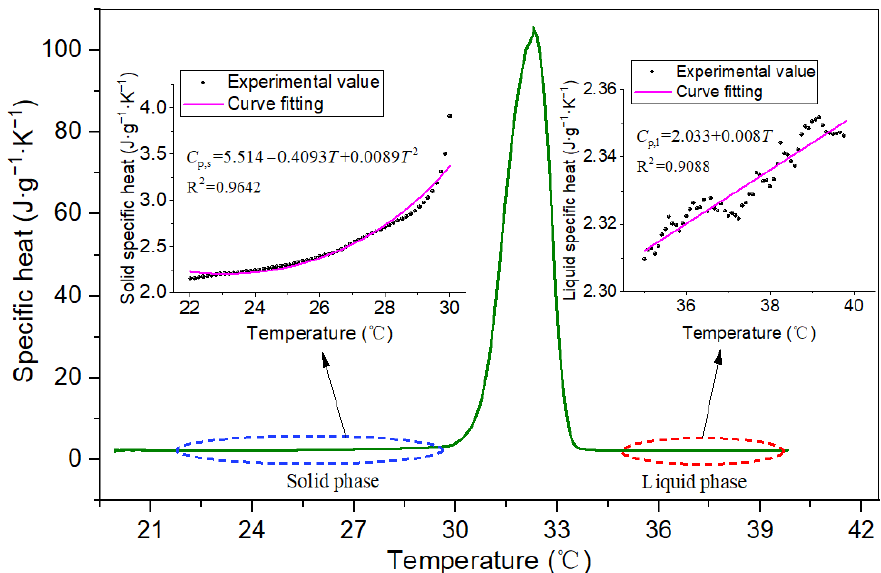
Figure 9. The specific heat capacity of PCM (0 wt.% EG).